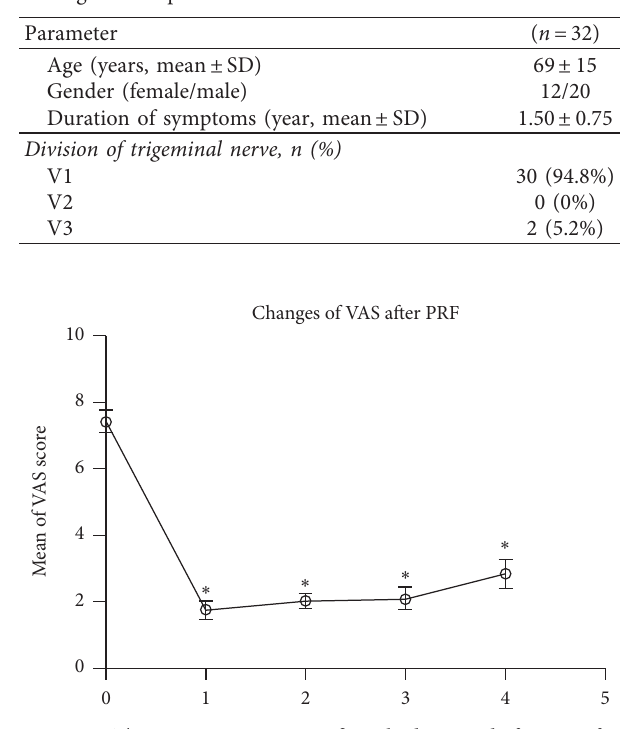
Table 1: Basic characteristics of patients for PRF to treat PHN of the trigeminal ophthalmic branch.